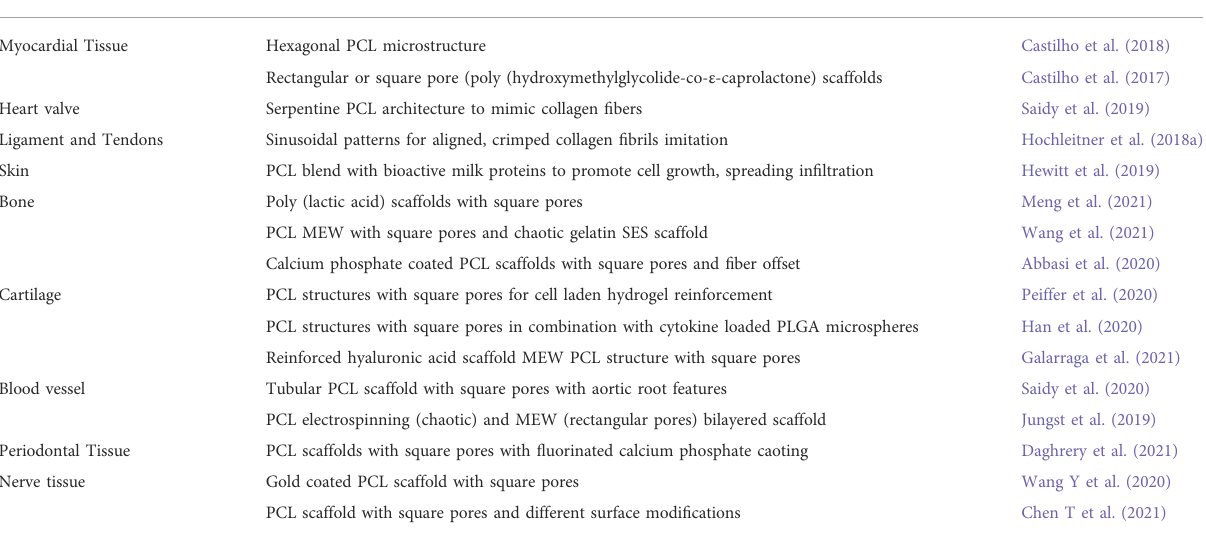
TABLE 1 Tissue speci fi c scaffolds fabricated via